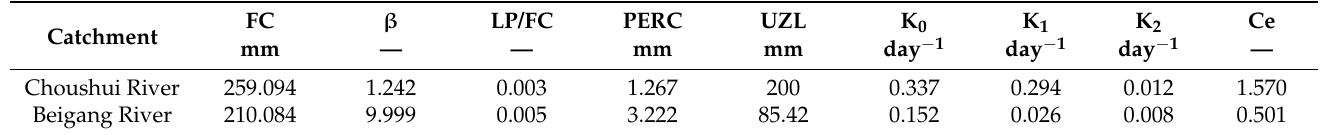
Table 7. Evaluation index of the modified HBV model in the Choushui River alluvial fan. Flow Ratio Correlation Coefficient Root-Mean-Squared Error Coefficient of Catchment